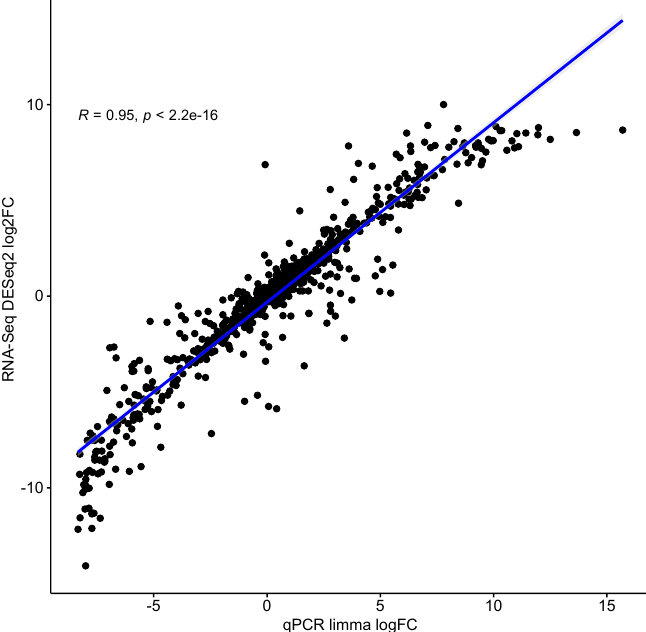
Figure A2. Logarithmized fold change correlation between limma results of qRT-PCR and pipeline results ( DESeq2 ) of RNA-Seq data filtered by adjusted p -value ≤ 0.01 of limma results. The correlation was calculated by the Pearson